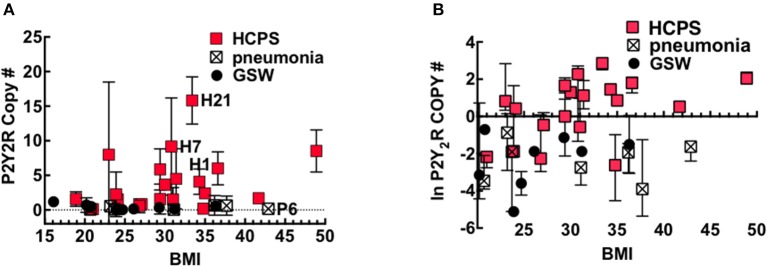
P2Y2R expression is significantly upregulated in HCPS compared to controls. Plots of (A) Mean and (B) Natural log-transformed values of P2Y2R copy numbers in 10 μm slices cut from the FFPE lung tissue blocks versus body mass index or BMI of Gunshot, pneumonia and HCPS cases. Error bars represent measurements of P2Y2R in slices from different segments of lung tissue from each case (indicated in Figure 3). Statistical analysis was performed on natural log-transformed data to approximate a normal distribution. See text for details.